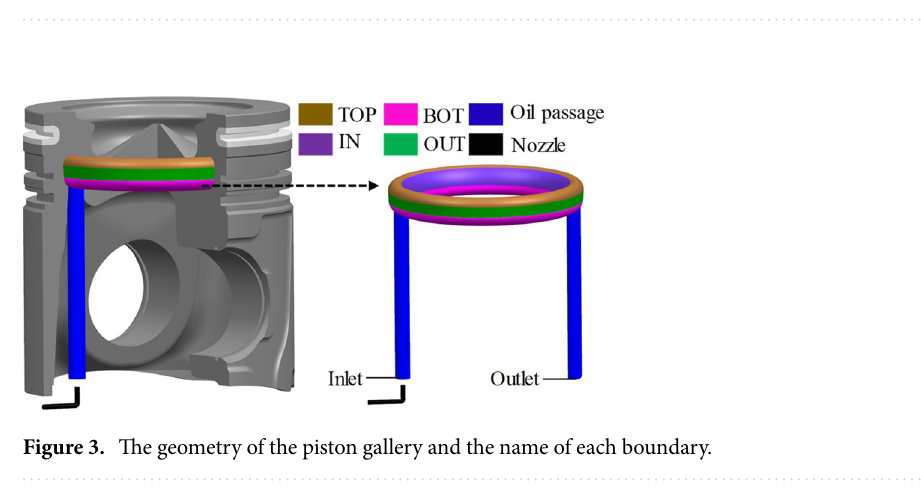
Table 5. Thermophysical parameters of the piston ring, pin, and rod.